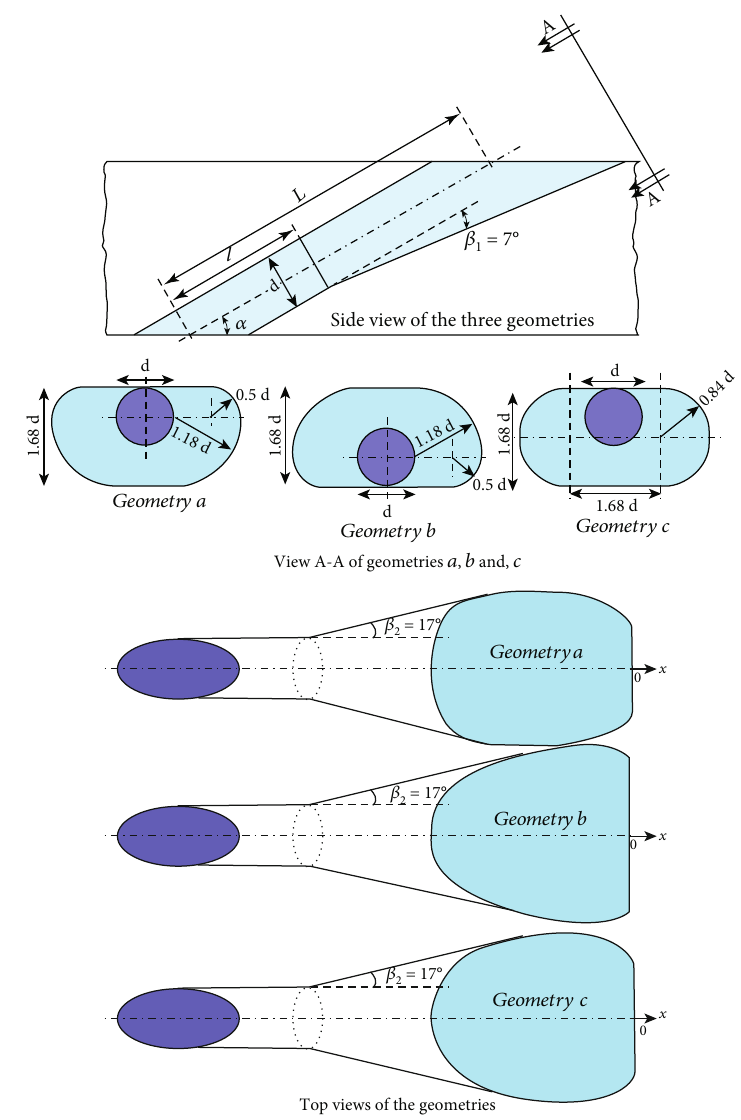
Figure 3: Details of the fi lm hole